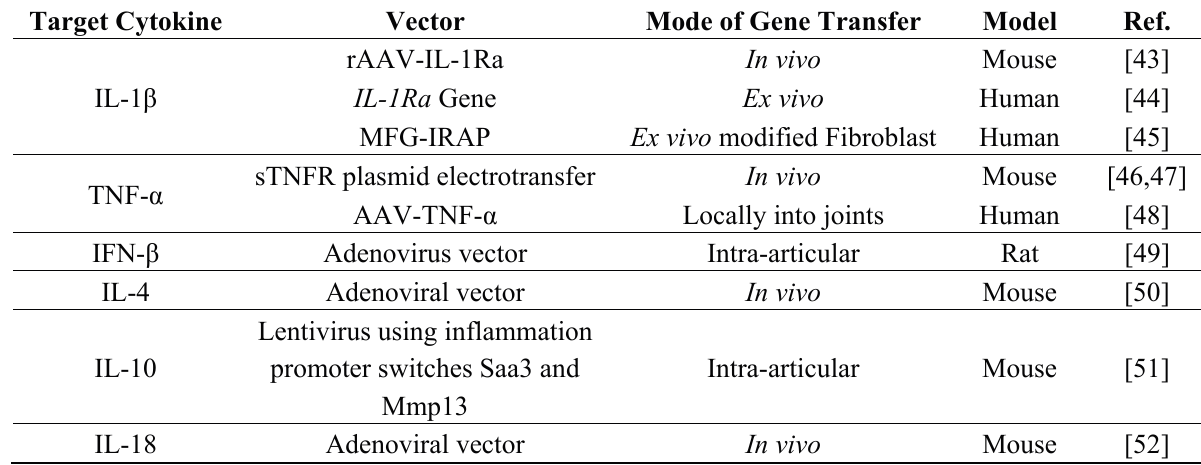
Table 2. Cytokine modulation by gene therapy for arthritis